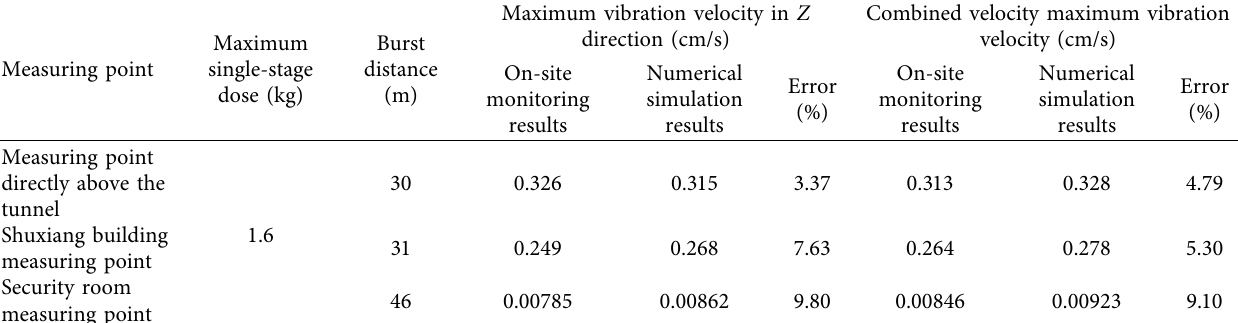
Figure 5: Layout of local damping holes. Table 4: Comparison of monitoring data and numerical simulation results.